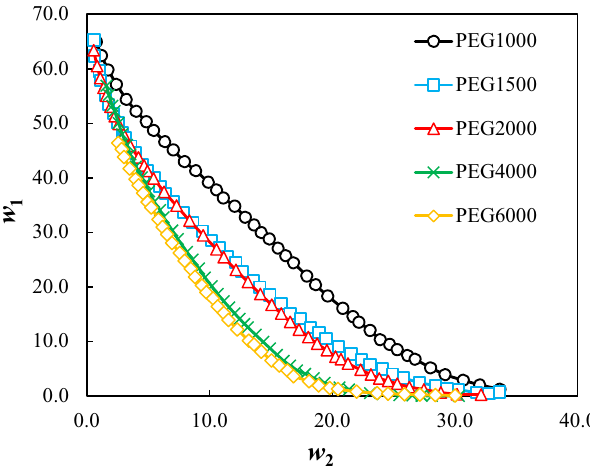
Figure 1. Effect of the molecular mass of PEG on binodal curves of PEG 1000,1500,2000,4000,6000 (1) + trilithium citrate (2) + water (3) system at T = 298.15 K and P = 101